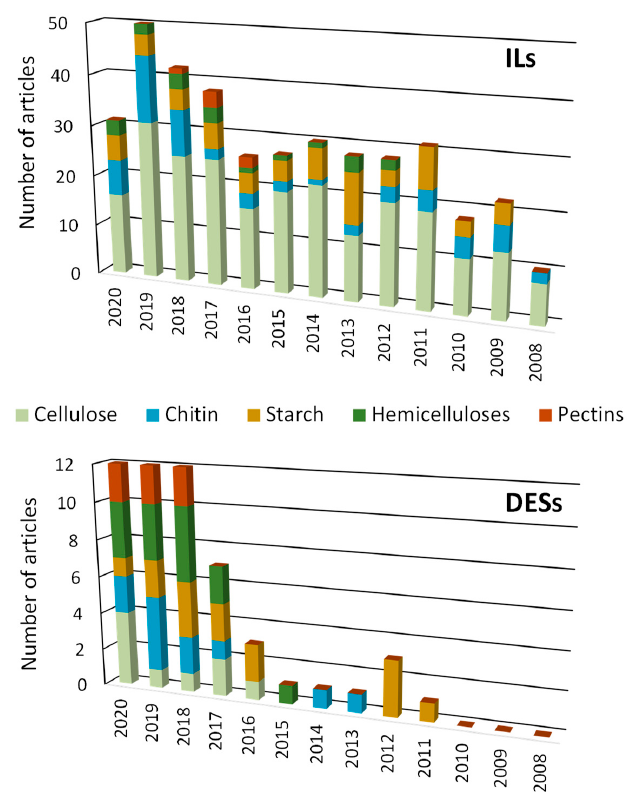
Figure 4. Number of articles published per year regarding the dissolution and extraction of the different types of polysaccharides covered in this review using ILs and DESs.